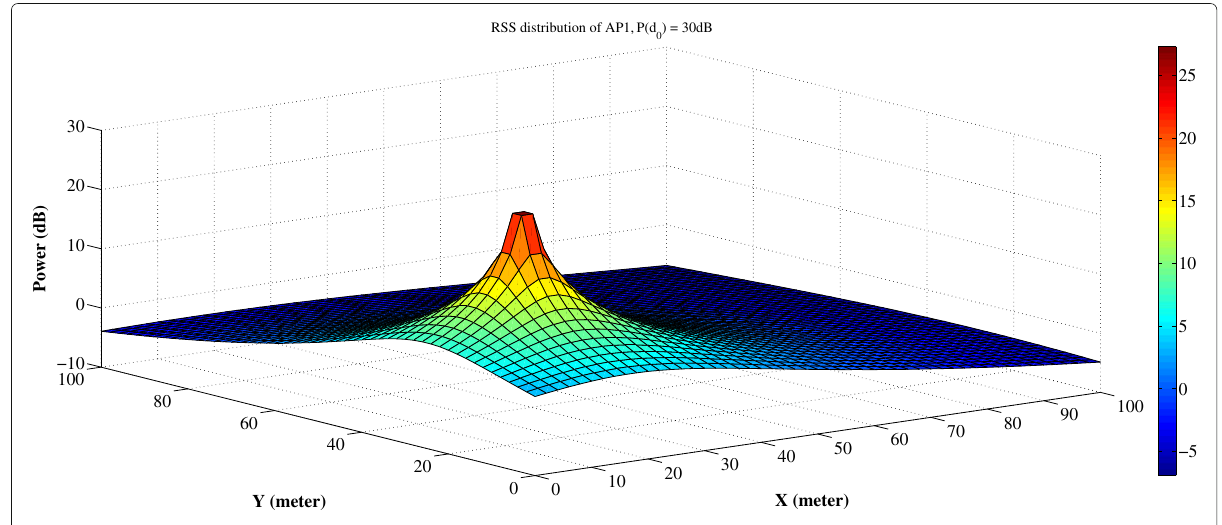
Fig. 9 RSS distribution of AP1. P ( d 0 ) = 30 dB, α = 1.8, d = 2 m, and σ = 5.2 dB